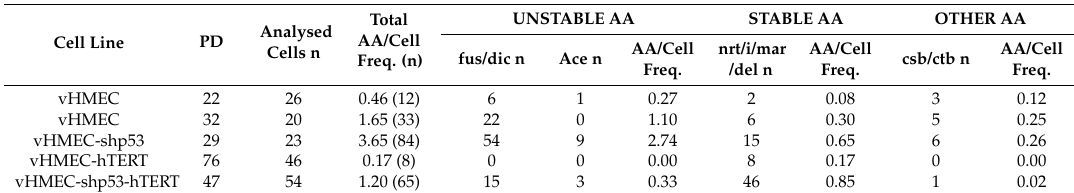
Table 2. Distribution of the types of structural chromosome